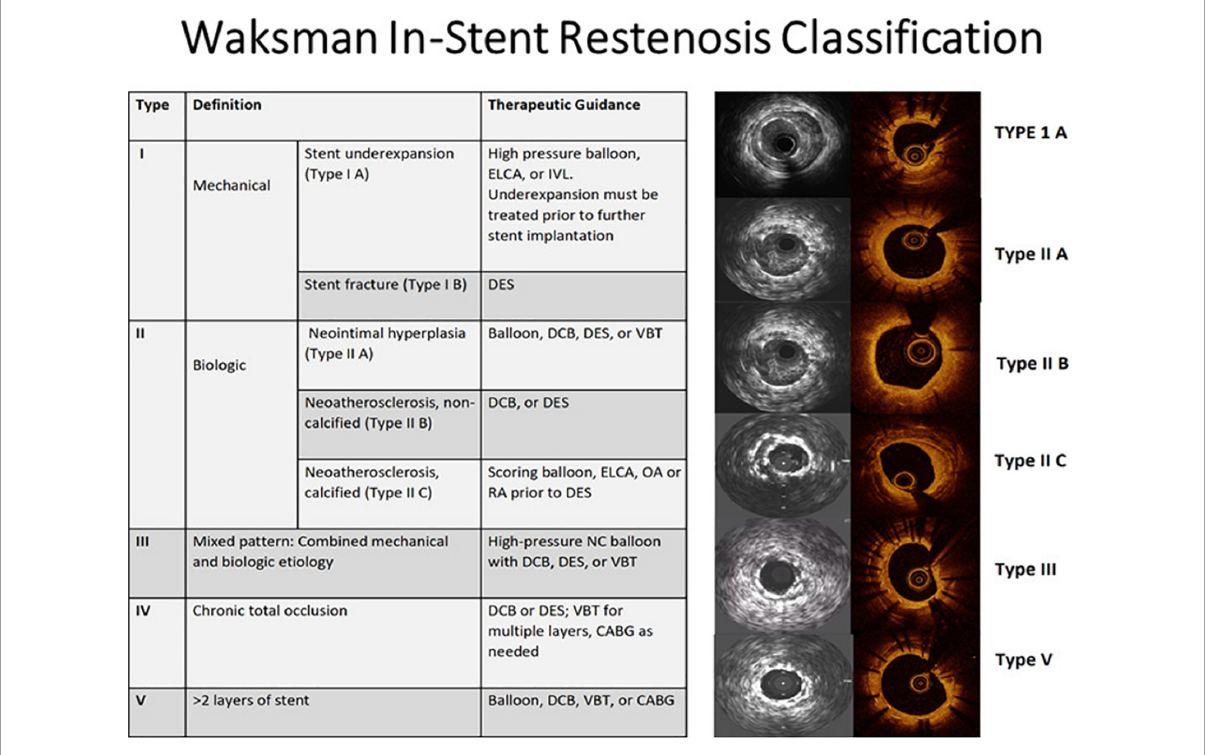
FIGURE14 Imaging-guided treatment of ISR. ELCA, excimer laser coronary atherectomy; IVL, intravascular lithotripsy; DES, drug-eluting stent; DCB, drug-coated balloon; VBT, vascular brachytherapy; OA, orbital atherectomy; RA, rotational atherectomy; NC, non-compliant; CABG, coronary artery bypass graft. Reproduced with permission from Shlofmitz et al.